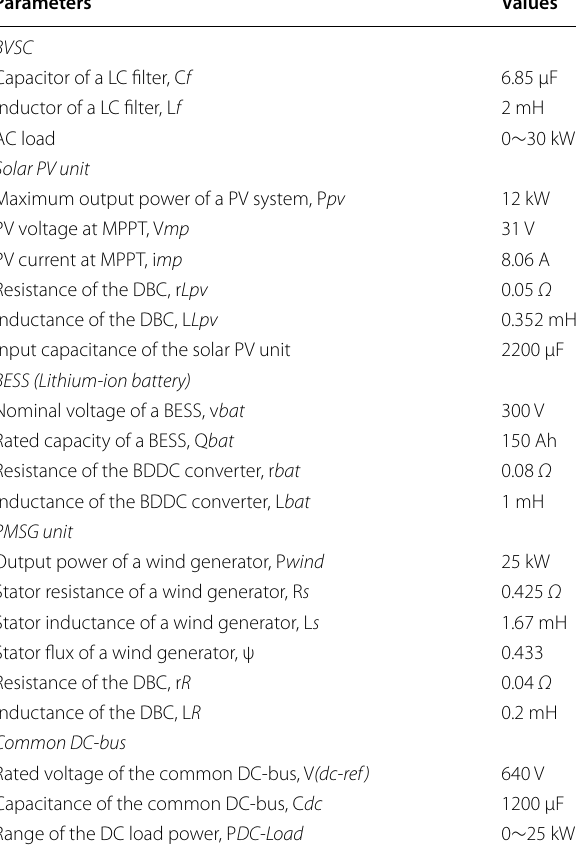
Table 1 Nominal parameters of the proposed hybrid AC/DC MG Parameters